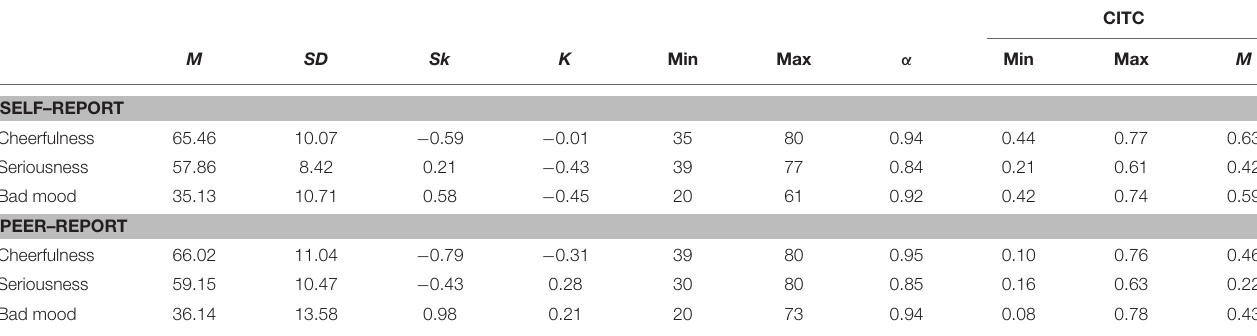
TABLE 11 | Descriptive statistics, corrected item to total correlation and reliability of the standard English version STCI–T < 60 > (self– and peer–reports) in the replication sample and peer–report